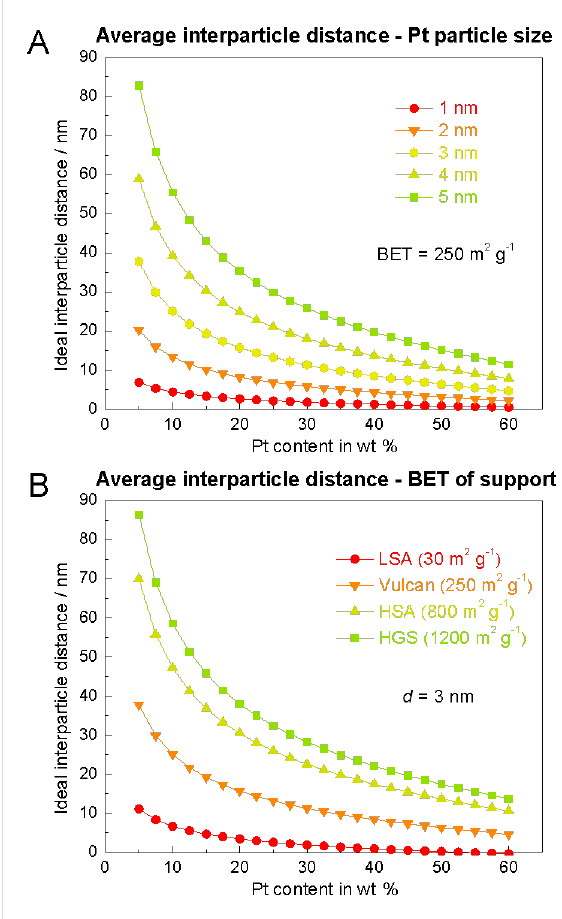
Figure 11: A) Dependence of the AID on platinum content for various platinum particle sizes, calculated for a Vulcan support (BET ca. 250 m 2 ·g − 1 ) using Equation 1. B) Dependence of the AID on platinum content for various specific support surface areas, calculated for a plat- inum particle diameter of 3 nm, by using Equation